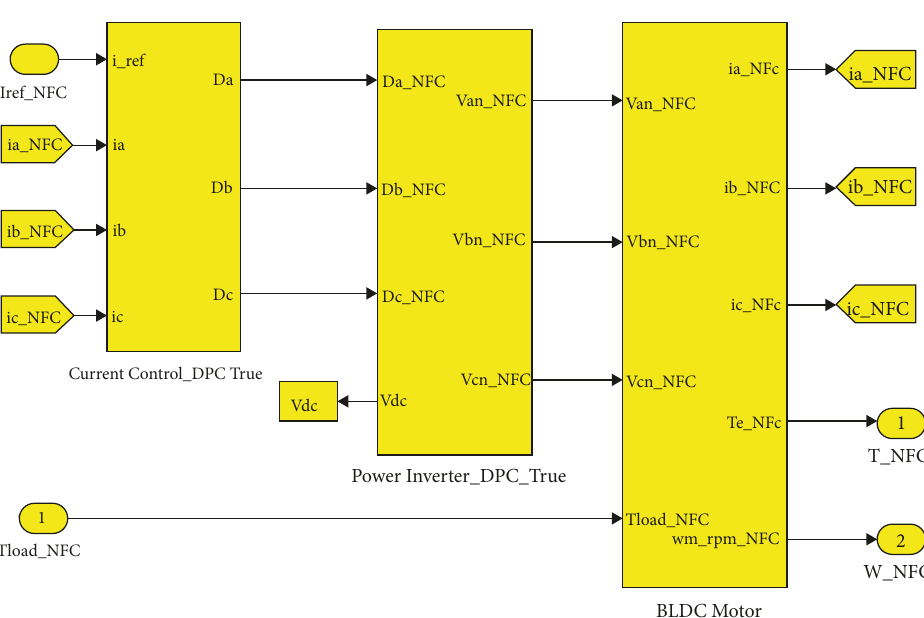
Figure 12: BLDC motor drive in Simulink [17].